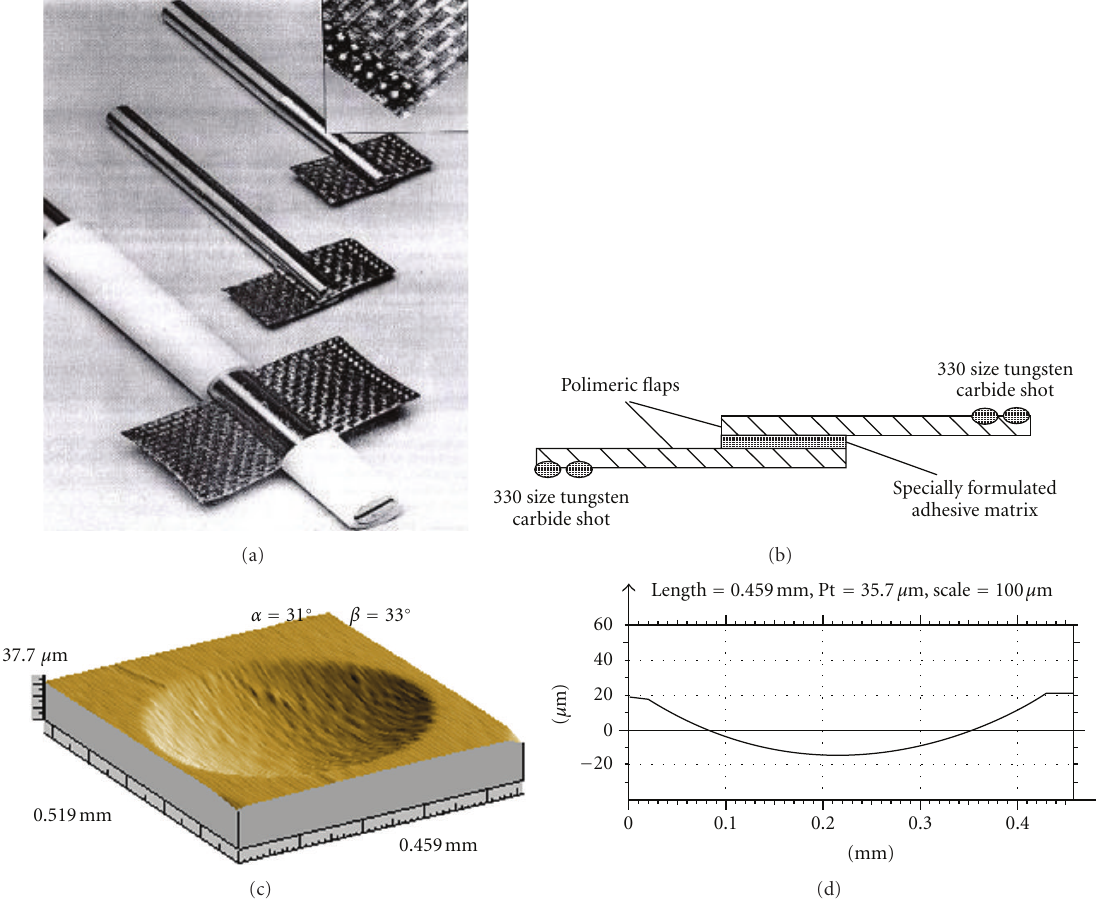
Figure 3: (a, b) Tools for the roto-peen machining; (c) view of a trace of a single ball hit; (d) its profilogram (Fn = 400 N; 34